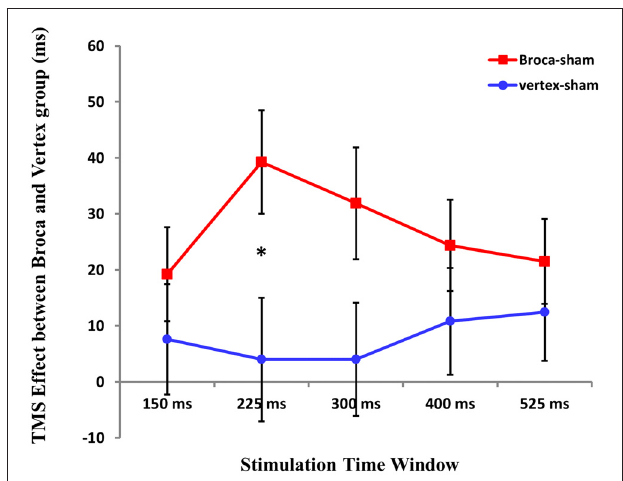
FIGURE 6 | The cost of the TMS effect between Boca’s and Vertex group at five time window. An asterisk means p < 0.05 (Bonferroni corrected).